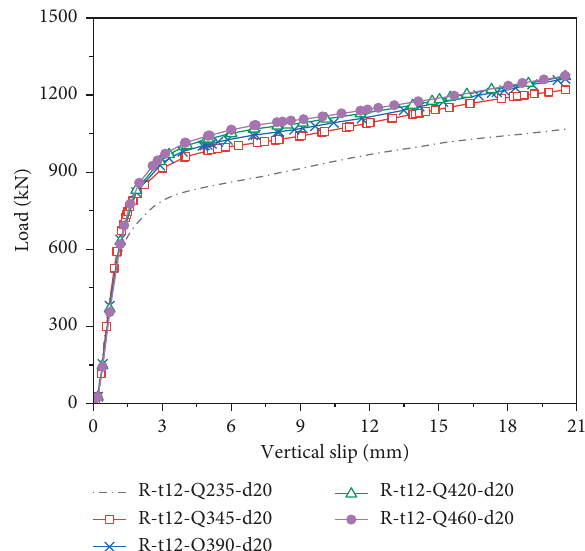
Figure 13: Load-slip curves for PBL with different steel strengths.